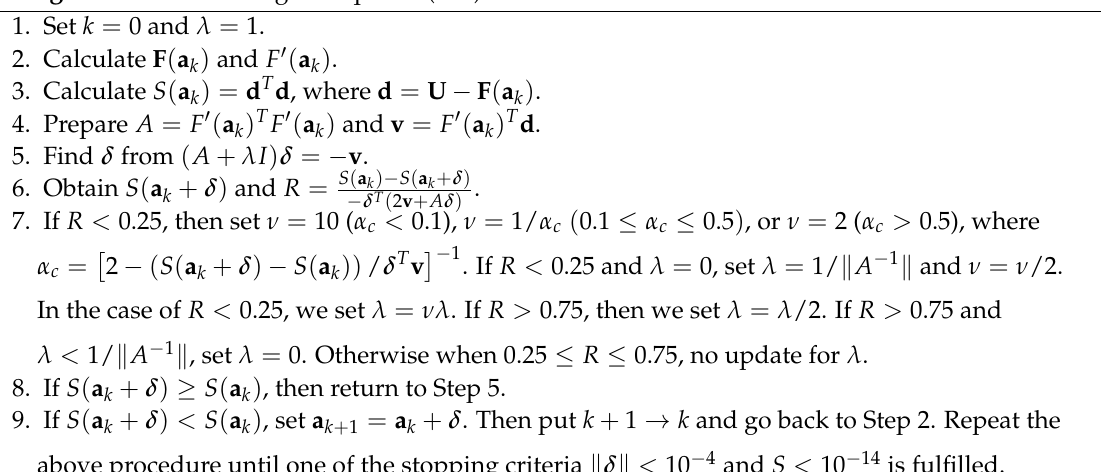
Algorithm 1: Levenberg–Marquardt